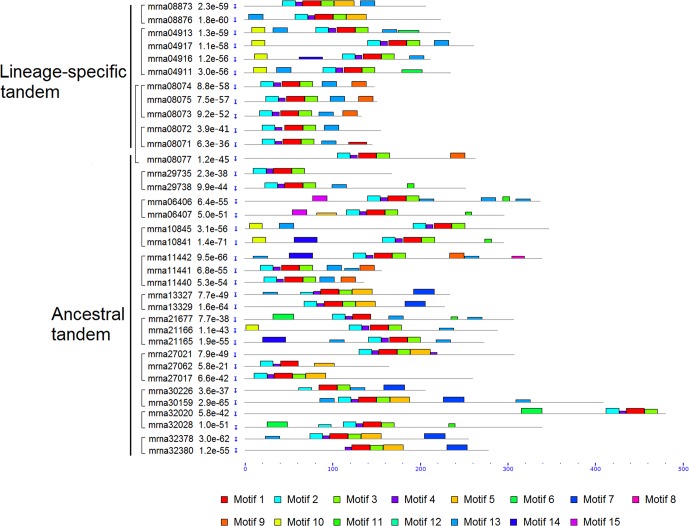
Schematic diagram of amino acid motifs of tandem FveERF proteins. Motif analysis was performed using MEME5.0.1 as described in the Materials and Methods. Proteins whose genes located in the same tandem repeat are grouped together. Mrna08077 forms an ancestral tandem repeat with mrna08071–mrna08075.